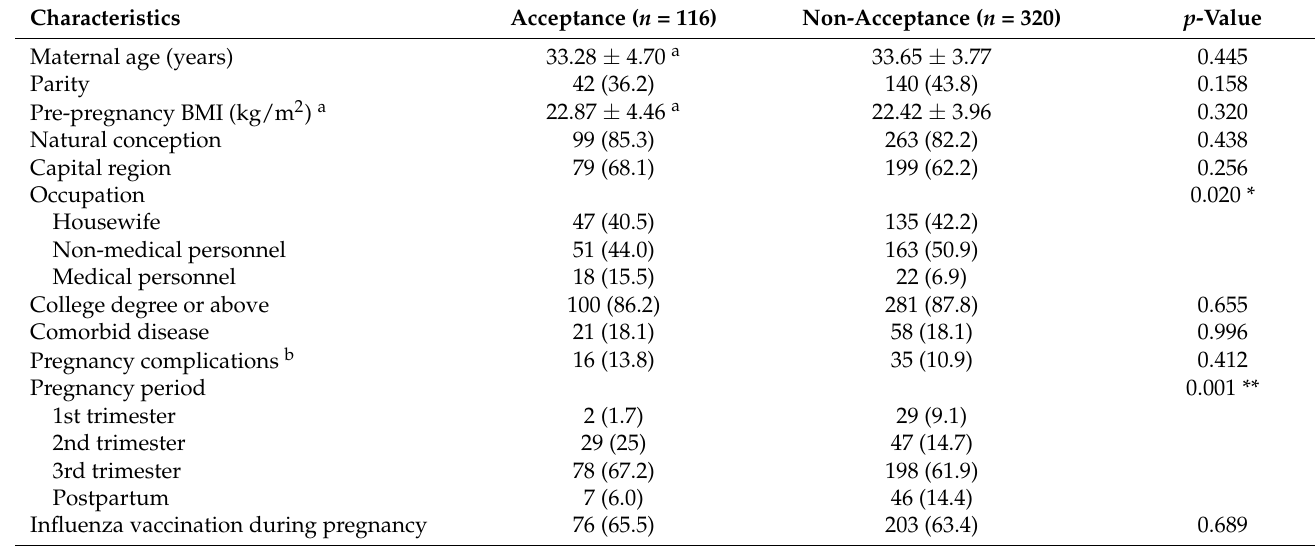
Table 1. Sociodemographic characteristics regarding COVID-19 vaccine acceptance.